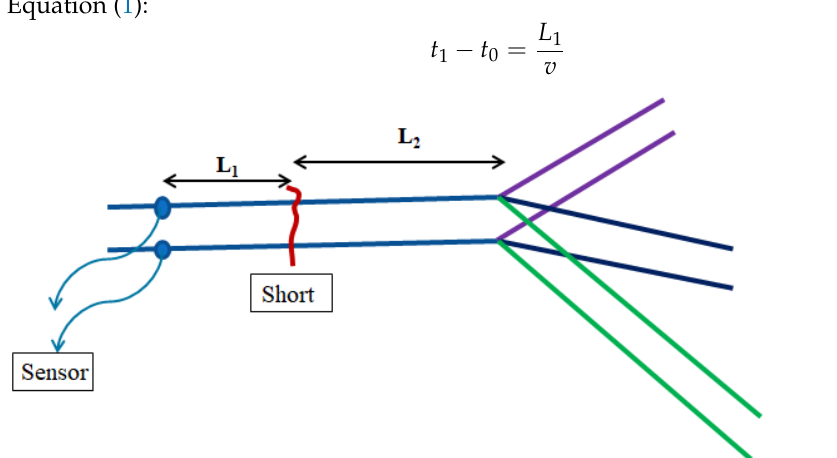
Figure 20. A short occurs between the sensor and the bifurcation point.